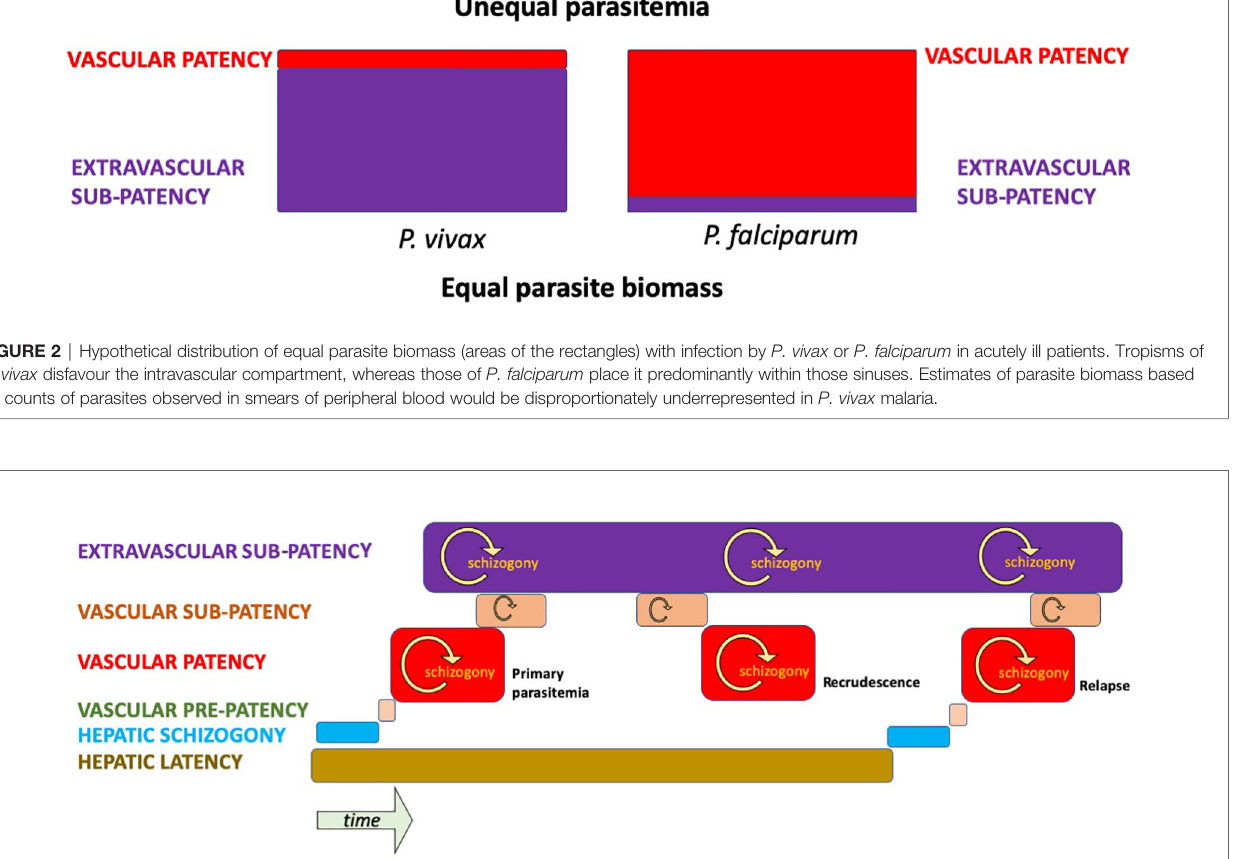
FIGURE 3 | Hypothetical infection by P. vivax of a semi-immune host illustrating stages and compartments of infection. Only vascular patency affords an opportunity for diagnosis and treatment by active case detection in an asymptomatic